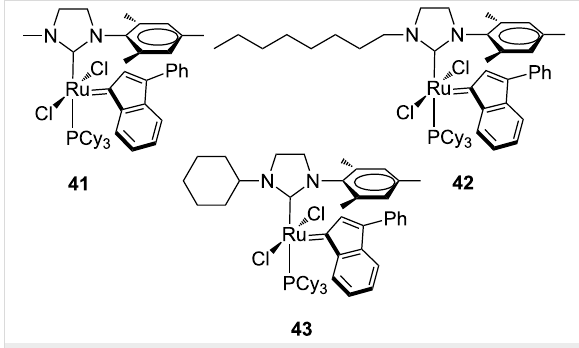
Figure 11: Indenylidene-type complexes 41 – 43 with N -alkyl, N ’-mesityl NHCs. For all of the complexes, two rotamers were observed in solu- with the indenylidene moiety located under the mesityl